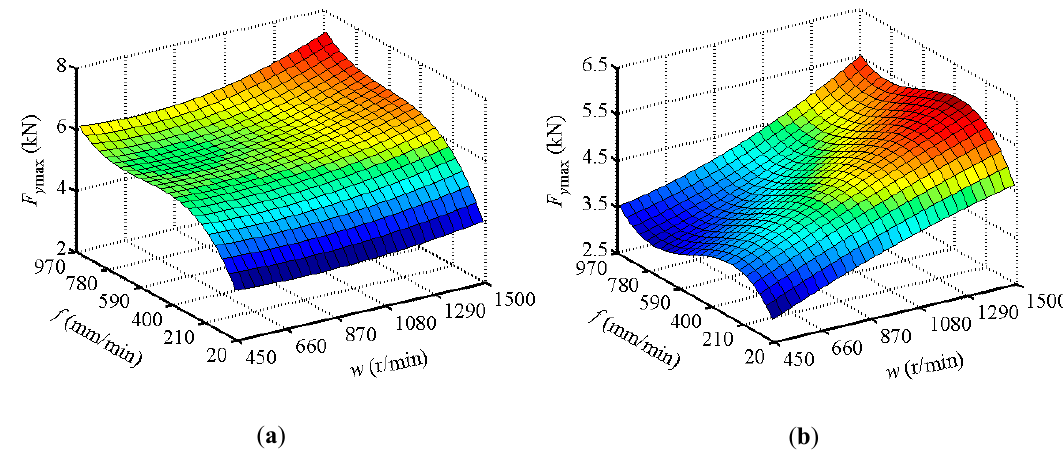
Figure 11. Surface graphs of F z am regression model: ( a ) Up-beating ( m = 1); ( b ) Down-beating ( m = –1).